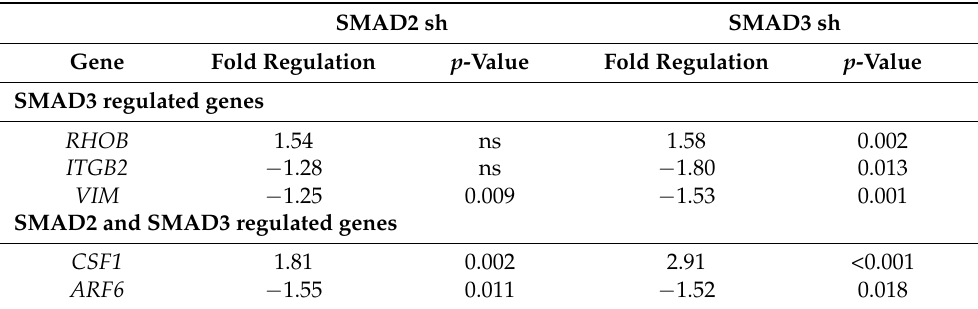
Table 3. SMAD2 and SMAD3 Depletion Affect the Transcription of Different Genes Involved in Cell Invasion. SMAD2 sh SMAD3 sh Gene Fold Regulation p -Value Fold Regulation p -Value